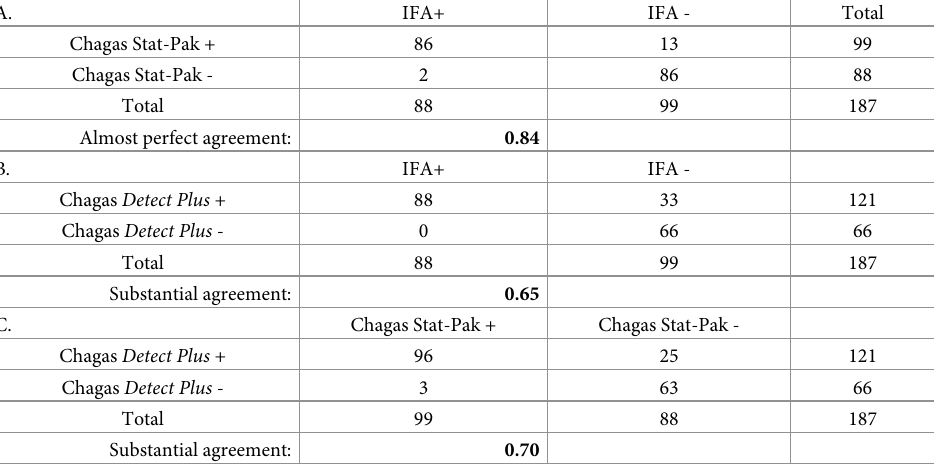
Table 4. Kappa Index table to statistically show pairwise comparisons and agreement among three serological tests: Chagas Stat-Pak, Chagas Detect Plus , and indirect fluorescent antibody (IFA) test. A. IFA+